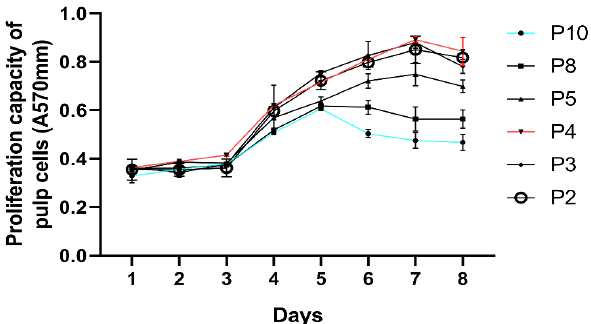
Fig. 1. Proliferation curves of human dental pulp stem cells at different